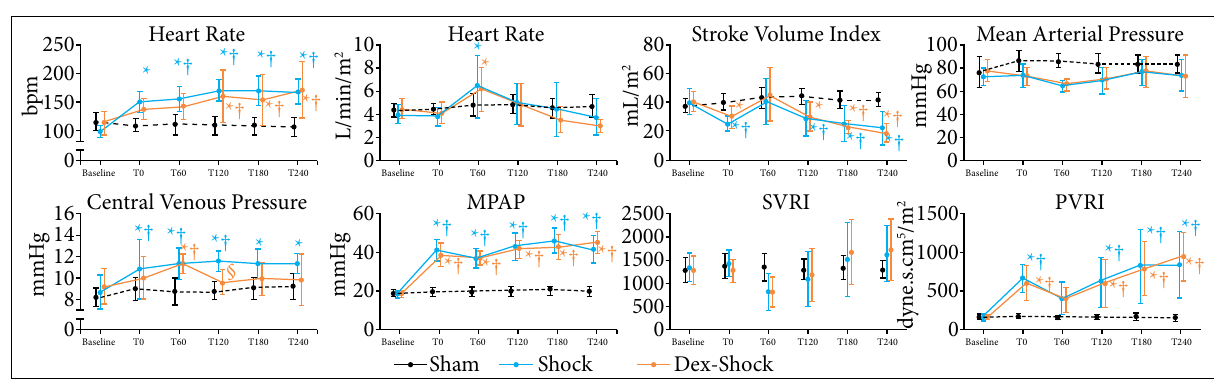
Figure 3 - Hemodynamic changes in anesthetized pigs (Sham group), septic shock animals (Shock group), and septic shock animals administered dexmedetomidine (Dex-Shock group) before bacterial infusion (baseline); at the end of bacterial infusion (T0); and 60 (T60), 120 (T120), 180 (T180), and 240 minutes (T240) after bacterial infusion.